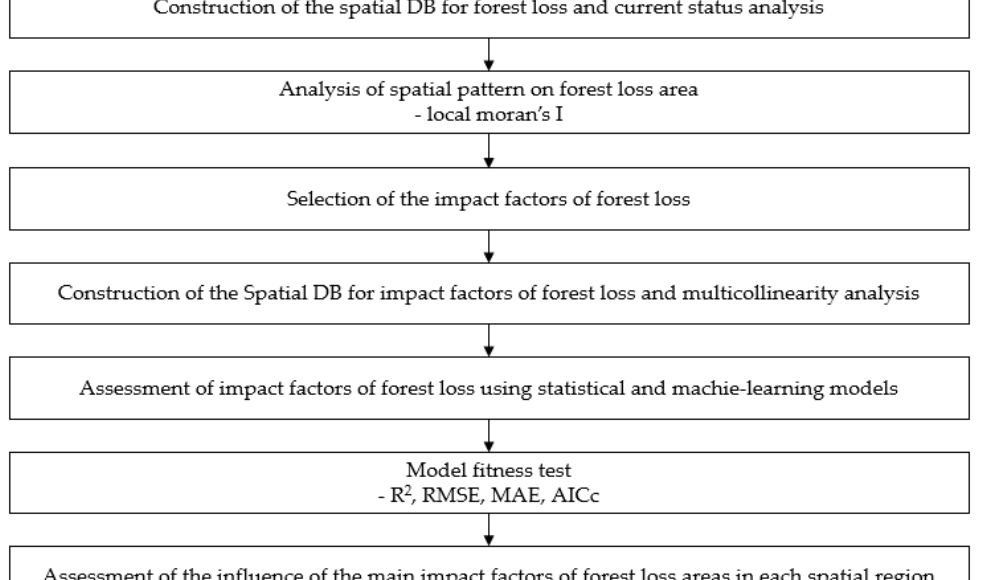
Figure 2. Workflow for analyzing the effects of factors on forest loss.